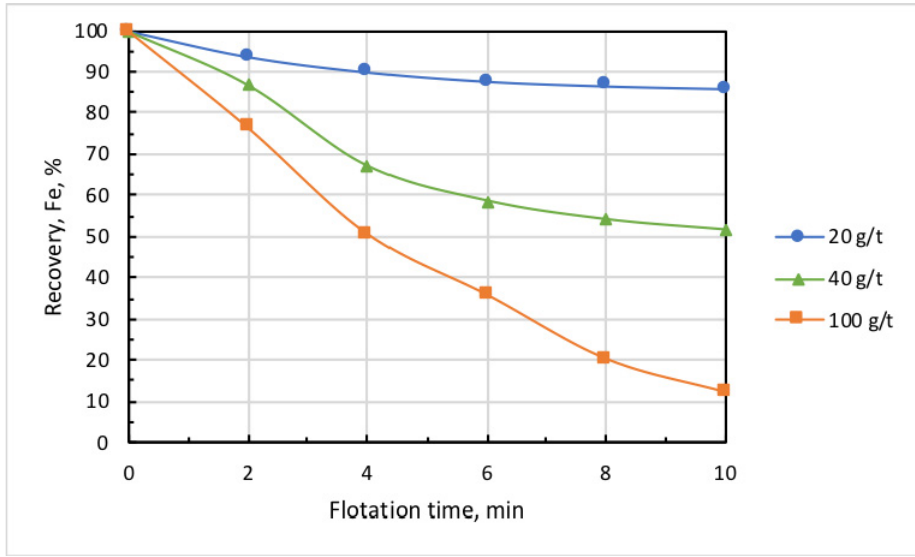
Figure 6. Kinetics of iron recovery at different doses of Lilaflot 821M collector. Airflow rate, 0.3 L/min.